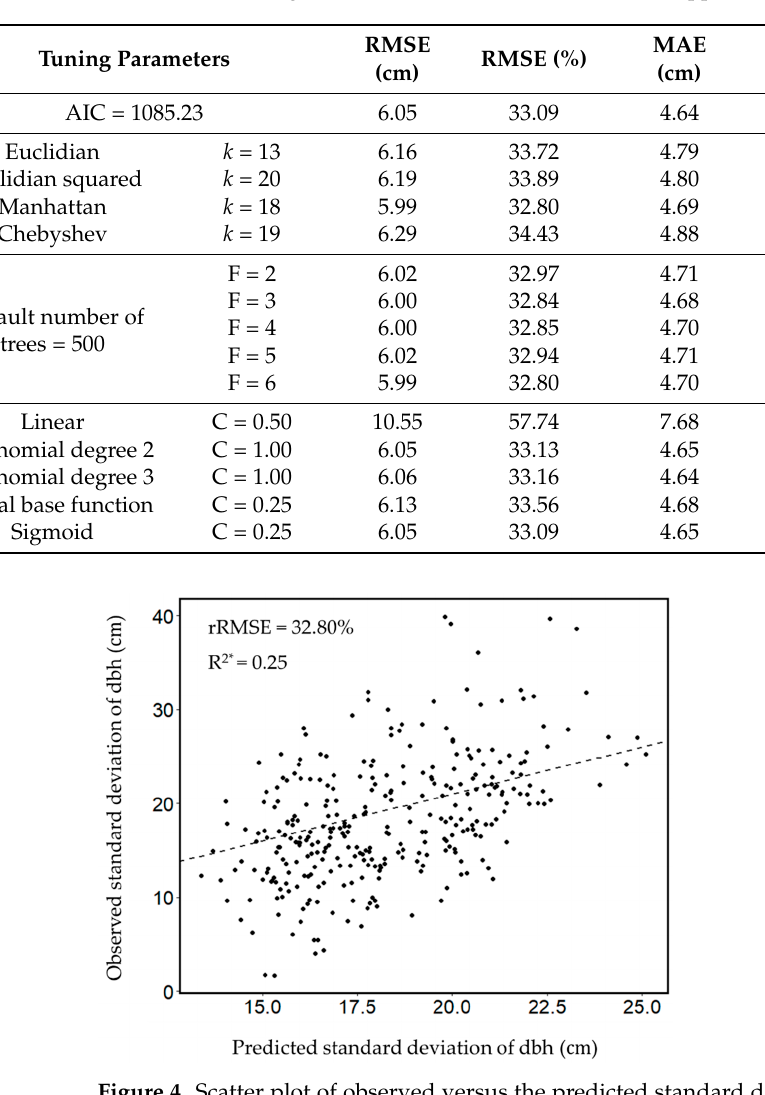
Table 5. Prediction accuracy of the number of trees ( 𝑁 ) using multiple linear regression (MLR), k - nearest neighbors ( k -NN), random forest (RF), and support vector regression (SVR) algorithms.